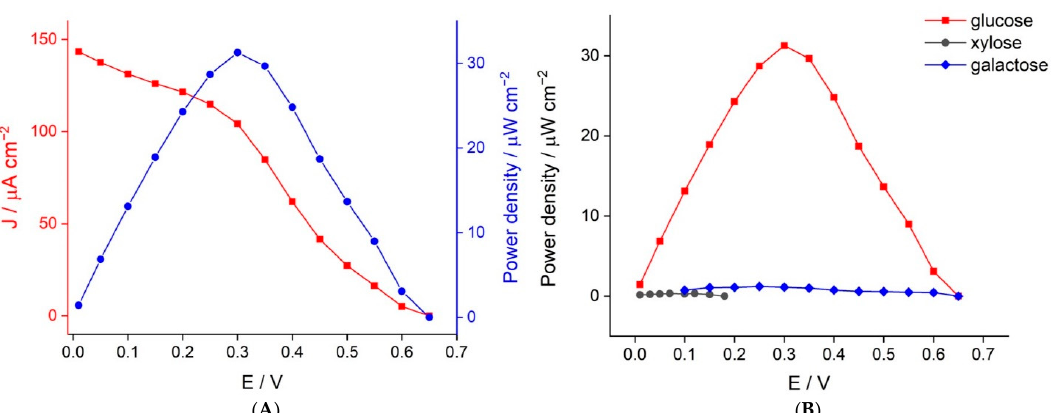
Figure 5. ( A ) Polarization and power density curves of the enzymatic biofuel cell operated in 40 mM glucose. ( B ) Power density curves of the enzymatic BFC in different sugars at a concentration of 40 mM in 0.1 M phosphate buffer pH 7.4 containing 5 mM NAD + .